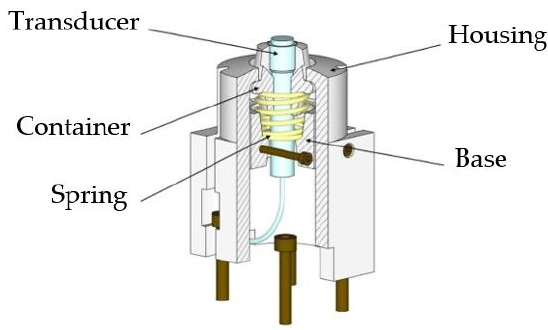
Figure 1. Isotropic cross-section view of the transducer fixture.